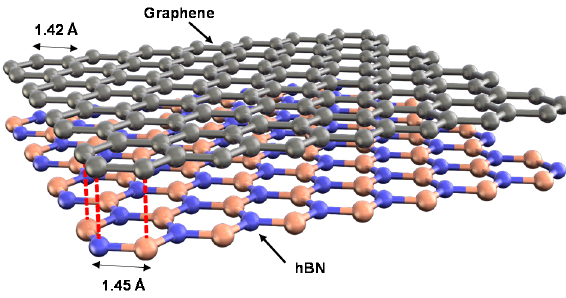
Figure 2. Lattice matching of graphene and